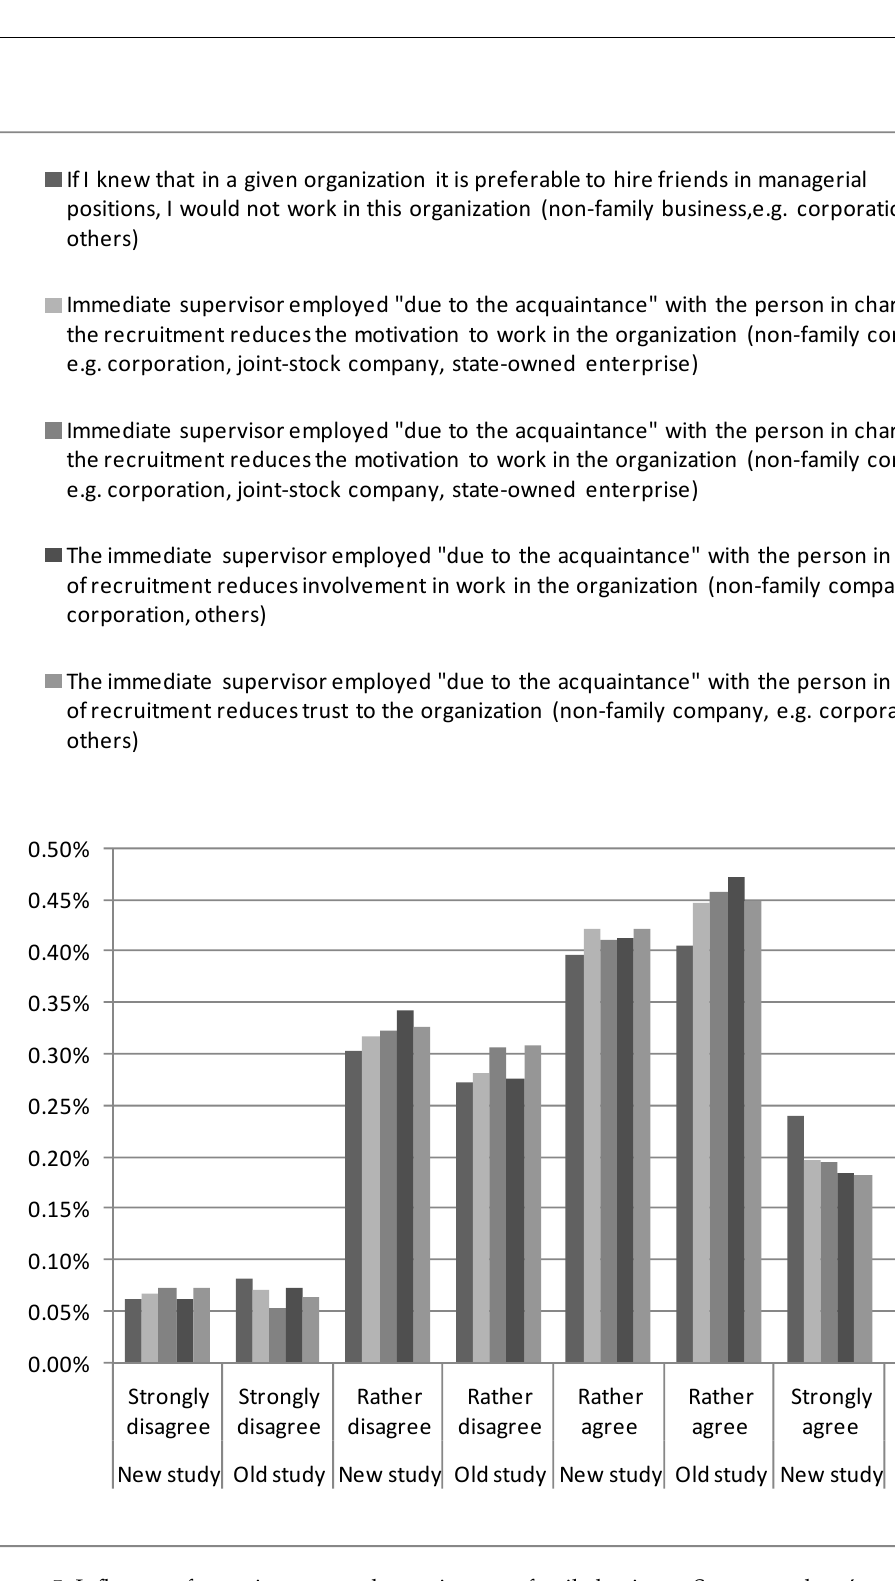
only 6.9% (76 people) strongly disagreed. A total 66.7% (328 people) of the respondents in the pre-Covid 19 pandemic study strongly agreed and rather agreed. In contrast, 38.3% (230 people) of the respondents to the study during the pandemic strongly disagreed strongly disagreed and rather disagreed. The difference between the old and the new